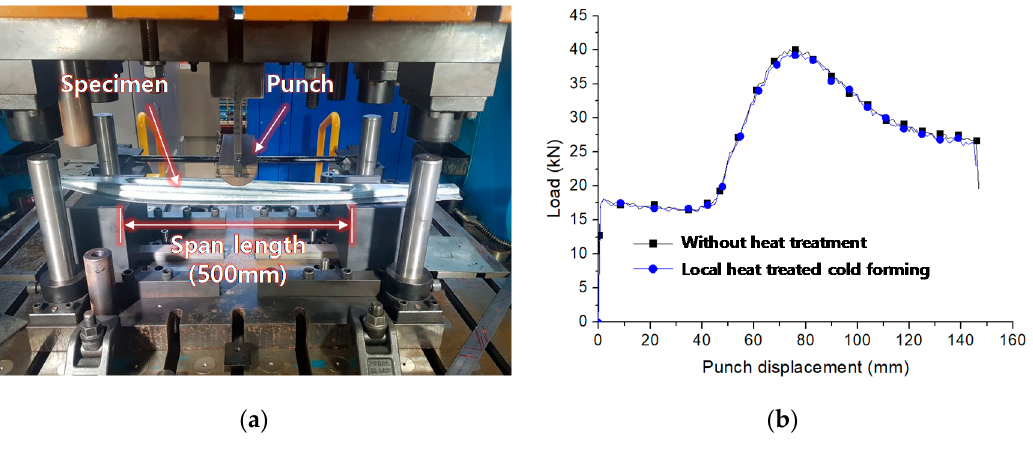
Figure 14. Three-point bending test for the door impact beam: ( a ) Experimental setting; ( b ) Load– displacement curves. ( b ) Load–displacement